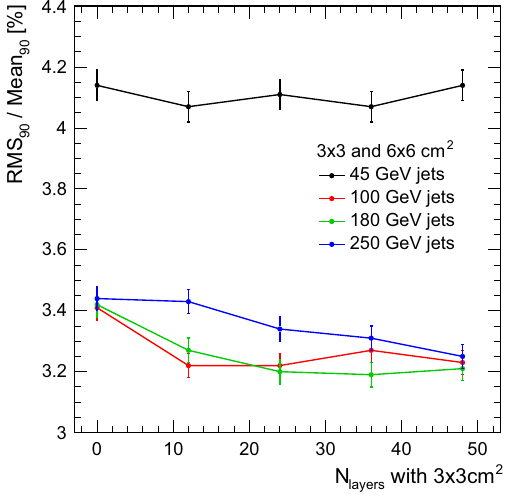
Fig. 13 Jet energy resolution with standard reconstruction (no soft- ware compensation, no energy truncation) as a function of the number of high granularity layers in the front part of the HCAL for different jet energies. Here, 0 corresponds to 6 × 6 cm 2 throughout the full calorime- ter, while 48 represents the scenario with 3 × 3 cm 2 granularity in the full system studied in the main part of this